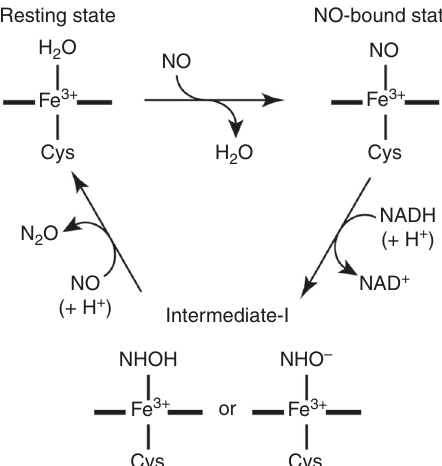
Fig. 1 Reaction cycle of P450nor. P450nor reduces NO to N 2 O through the NO-bound state and intermediate-I